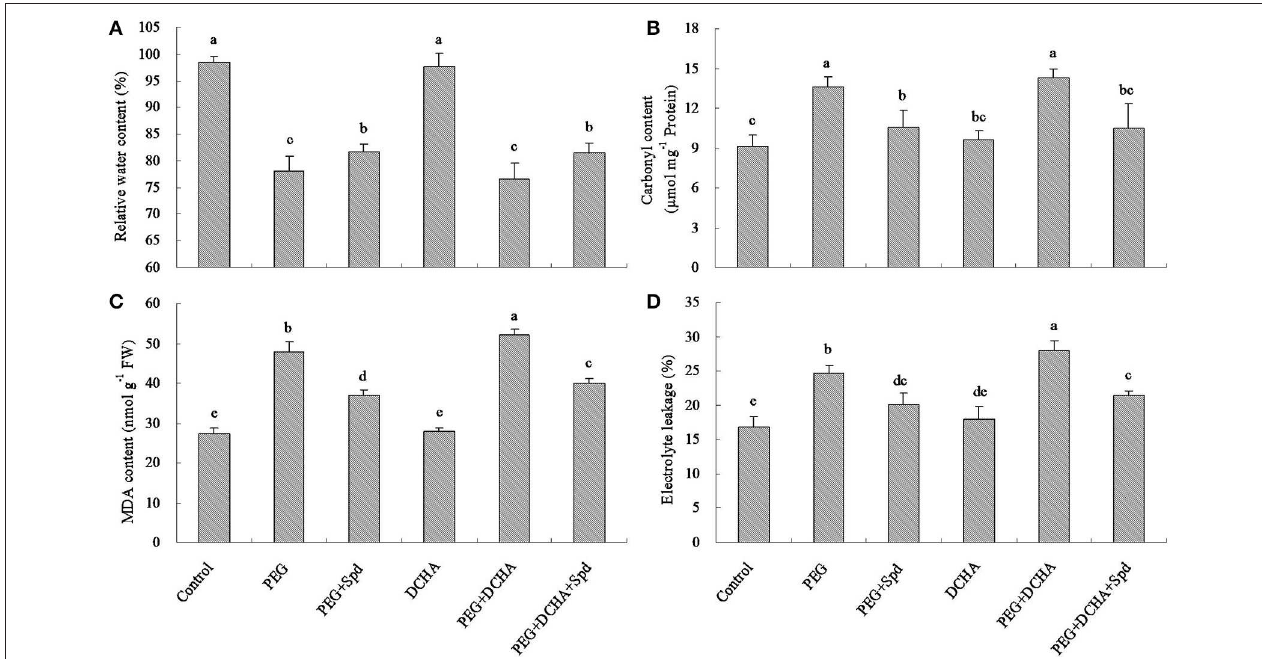
FIGURE 4 | Effects of spermidine (Spd) and inhibitor (DCHA) of aminopropyl transferase on PEG 6000-induced relative water content (A), carbonyl content (B), malondialdehyde content (C) and electrolyte leakage (D). The detached leaves of white clover were pre-treated with distilled water for 1h to eliminate wound stress and then treated for 12h as follows: 1, distilled water (control); 2, 15% PEG; 3, 15% PEG + 20 µ M Spd; 4, 100 µ M dicyclohexylamine (DCHA); 5, 15% PEG + 100 µ M dicyclohexylamine (DCHA); 6, 15% PEG + 100 µ M DCHA + 20 µ M Spd. Means of six independent samples are presented. Bars represent standard errors. The same letter indicates no significant difference (LSD) at P < 0.05.